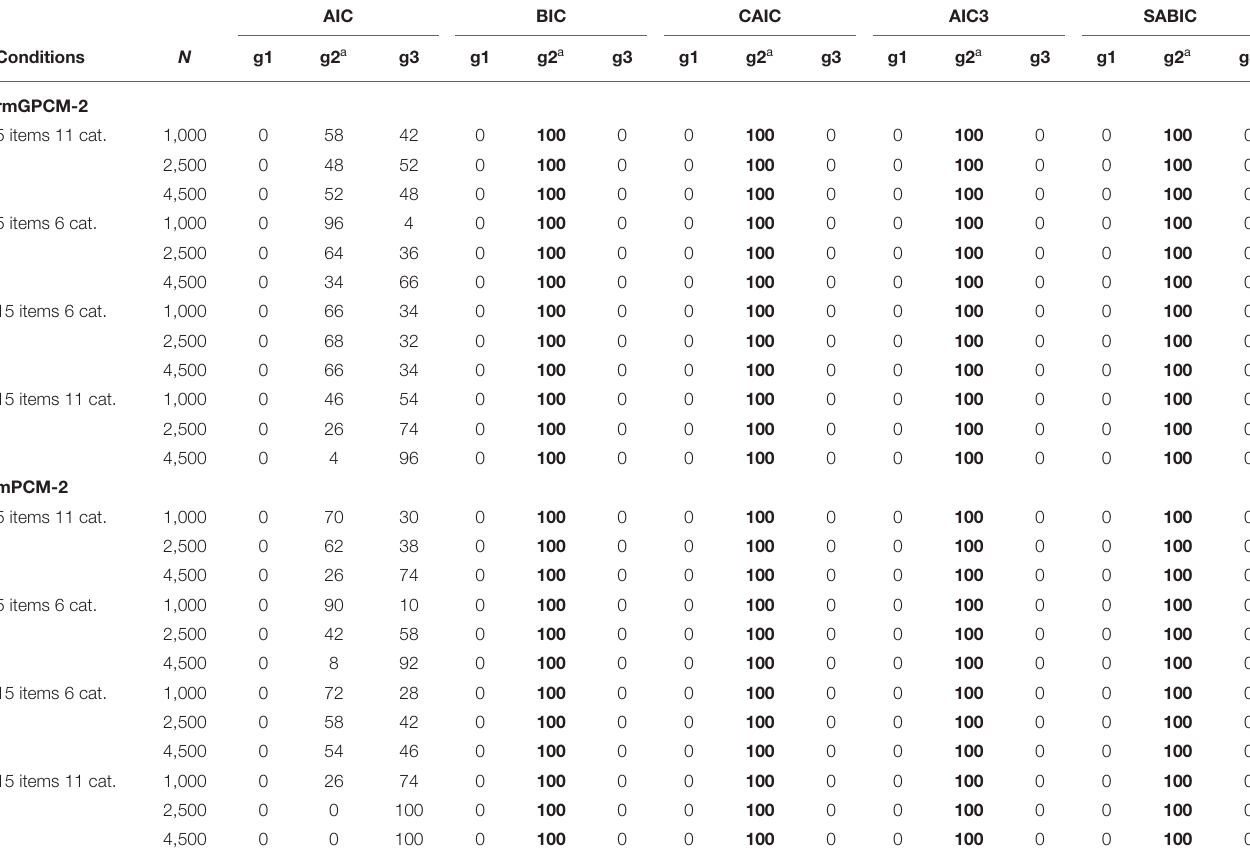
TABLE 8 | Model selection for the rmGPCM and the mPCM under the condition of a true two-class mixture. AIC BIC CAIC AIC3